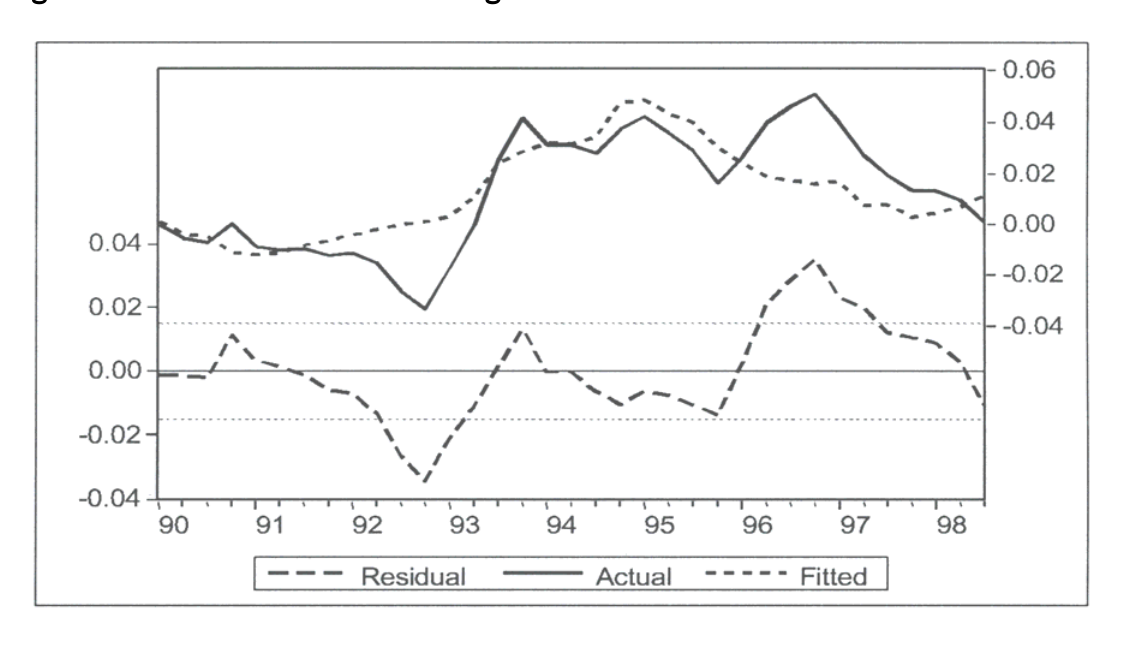
Figure 7 Goodness-of-fit of regression short-rates on GDP